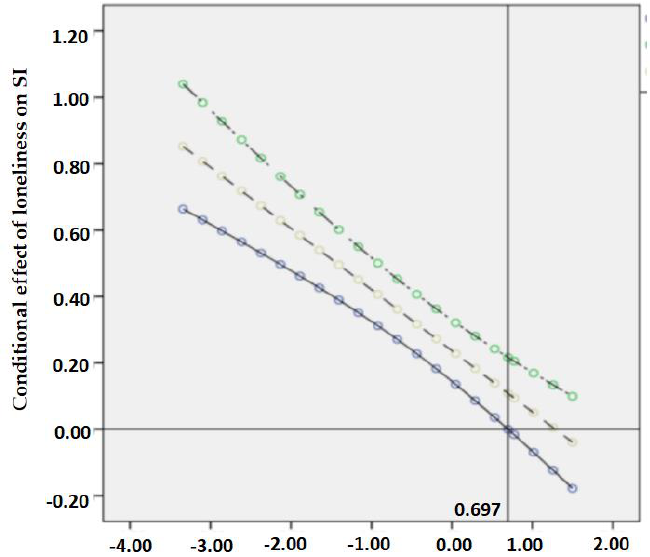
Figure 3. A plot of the effect of loneliness on SI at values of resilience.